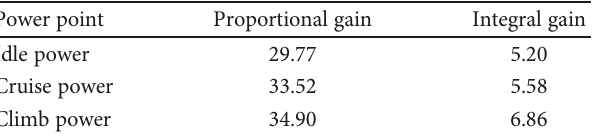
versus time (s). 1 Table 4: PI speed controller